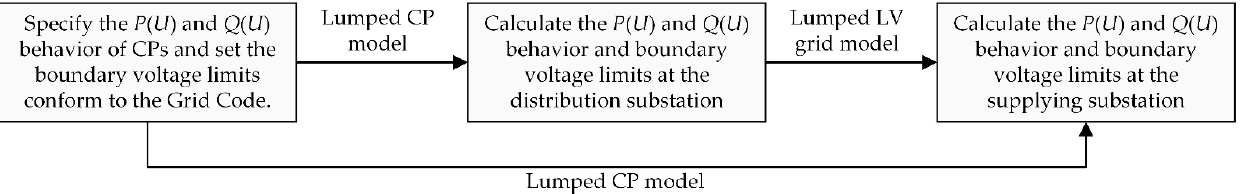
Figure 2. Overview of the LINK -based chain modeling procedure used to analyze the behavior of the test grids at distribution and supplying substations.